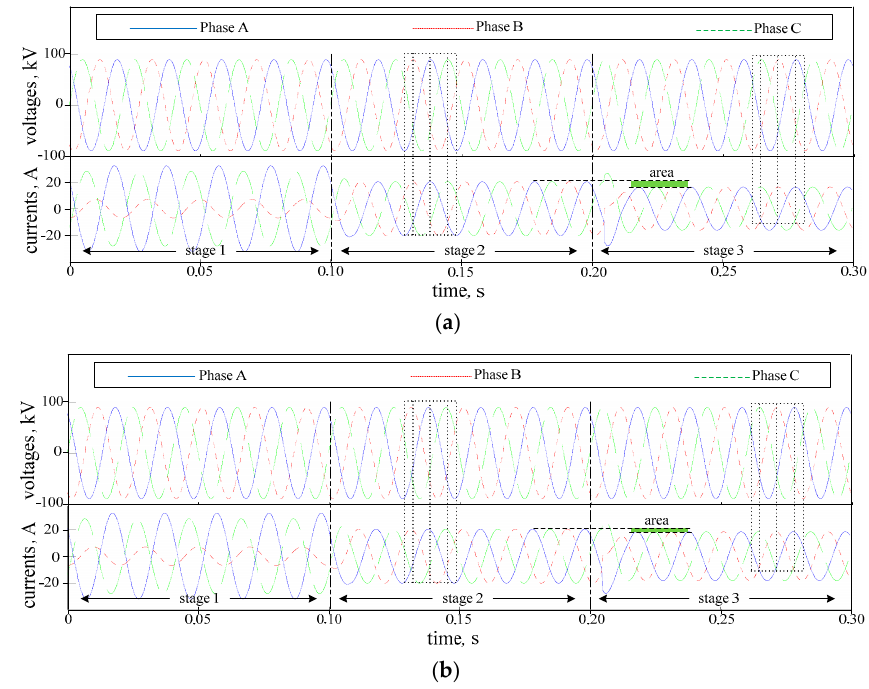
Figure 26. Results of power quality improvement under decentralized control and centralized control ( a ) decentralized control; ( b ) centralized control.